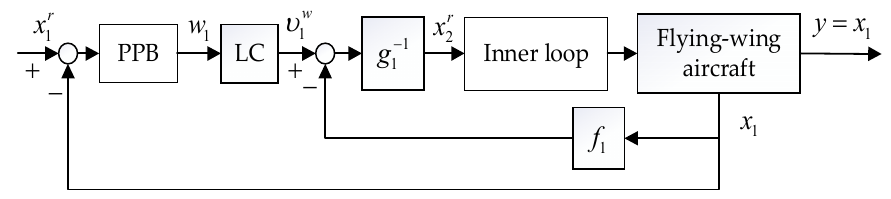
Figure 3. Outer loop control.